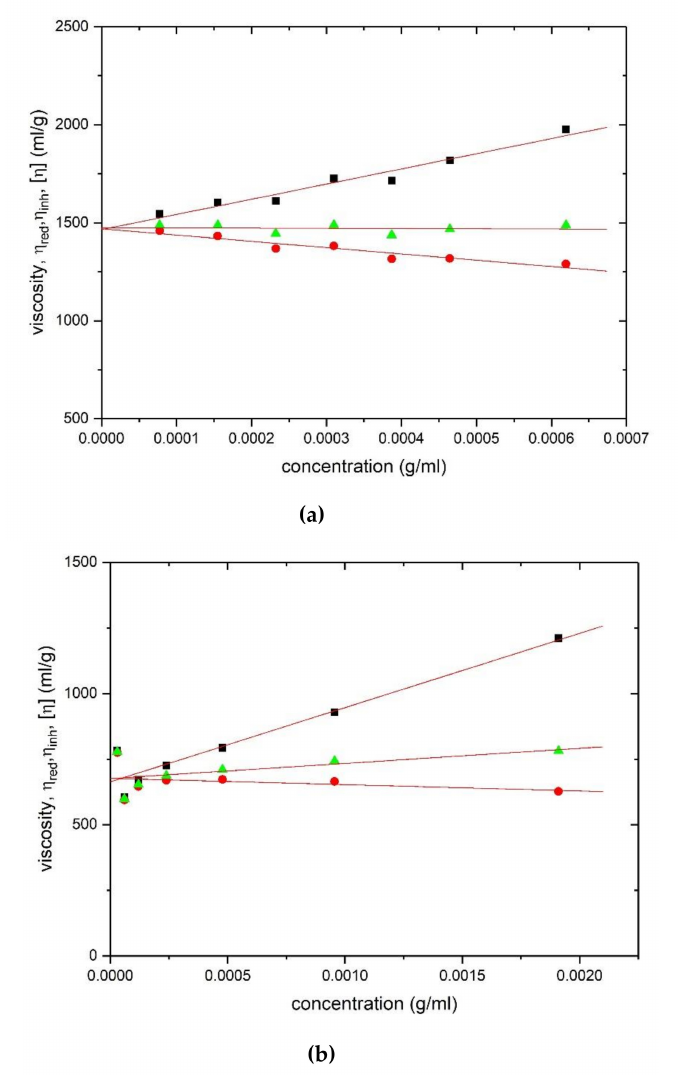
Figure 4. Evaluation of the intrinsic viscosity [ η ] from Ostwald viscometry: ( a ) hyaluronic acid and ( b ) tamarind seed polysaccharide. Squares: Huggins’ extrapolation; triangles: Solomon–Ciuta; circles: Kraemer extrapolation. Solution pH = 6.8, I = 0.1, temperature = (20.00 ± 0.05) ◦